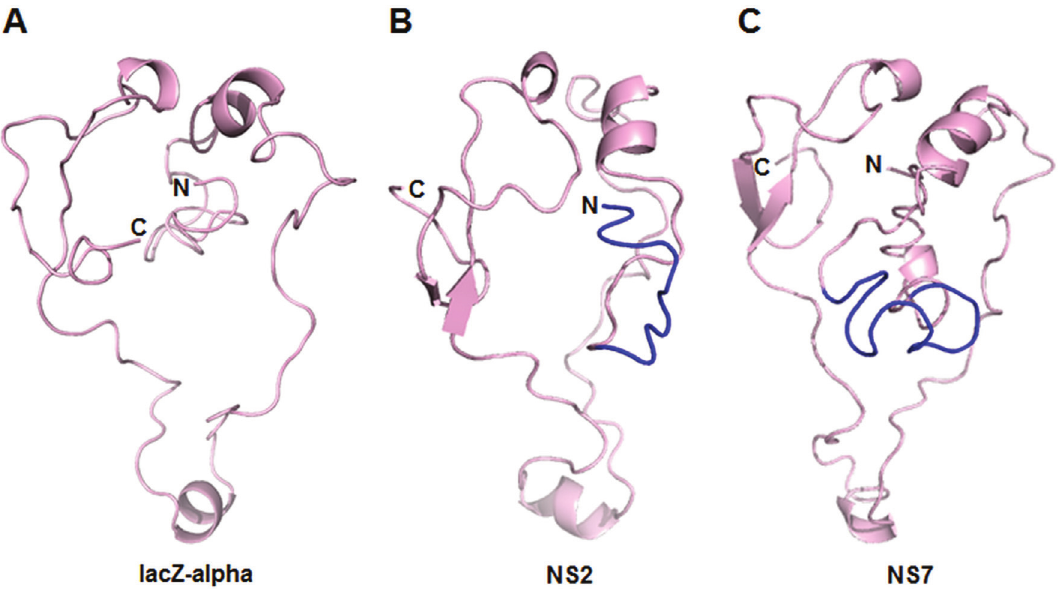
Figure 5 - Structural models of the (cid:3) -galactosidase LacZ (cid:2) -peptide (A) and chimeric peptides NS2 (B) and NS7 (C) resulted from the in frame metagenomic DNA insertion. In light pink is shown the 3D structure corresponding to the lacZ (cid:2) -peptide and in blue the metagenomic inserts. The ITASSER and PyMol softwares were used for structural model’s generation and visualization, respectively.